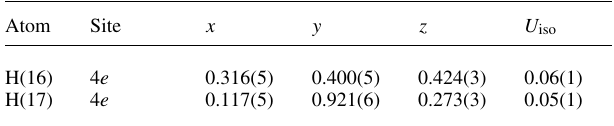
Table 2. Atomic coordinates and displacement parameters (in Å 2 ) .